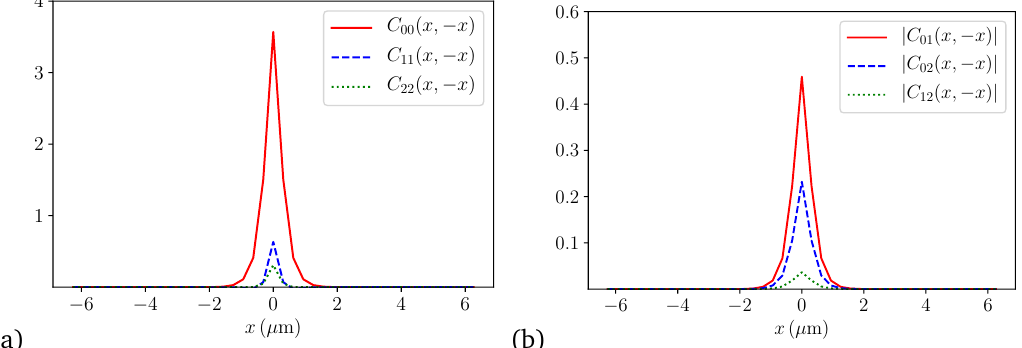
( x , y ) of interest, with the ij